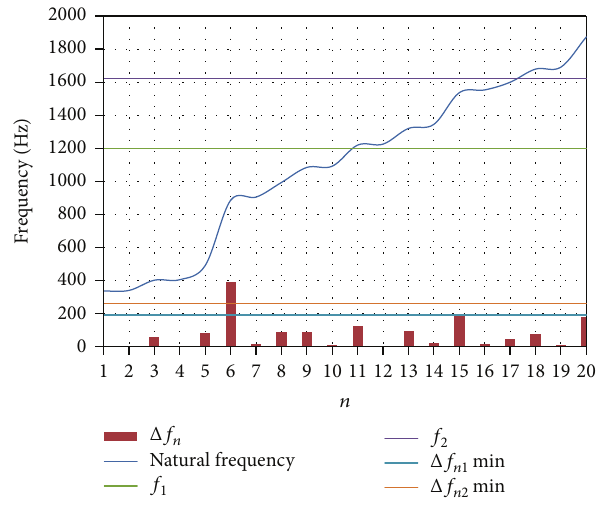
Figure 17: Frequency analysis